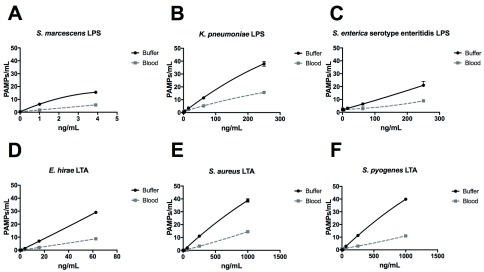
FcMBL ELLecSA screening of purified lipopolysaccharide (LPS) and lipoteichoic acid (LTA).LPS from (
A)
S. marcescens, (
B)
K. pneumoniae, and (
C)
S. enterica serovar enteritidis, and LTA from (
D)
E. hirae, (
E)
S. aureus, and (
F)
S. pyogenes were spiked into either TBST 5 mM CaCl
2 buffer or whole human blood at indicated concentrations.